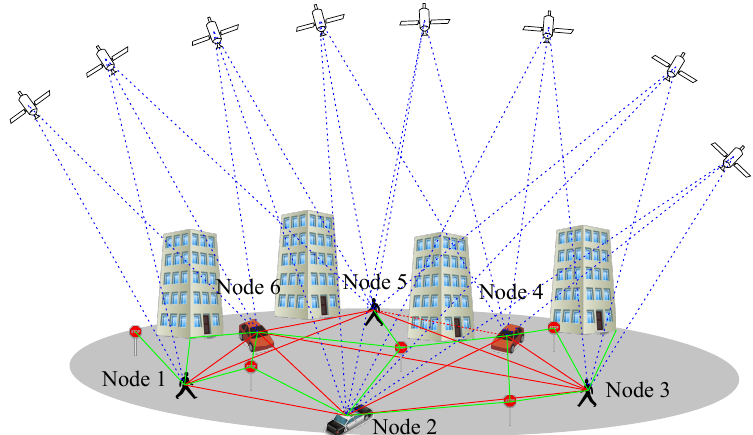
Figure 1. Collaborative positioning by vehicle-to-vehicle, vehicle-to-infrastructure and vehicle-to-pedestrian schemes. In addition, GNSS signals are received. The inter-nodal measurements are carried out using, e.g., laser scanners, stereo cameras and relative GNSS. Vehicle-to-infrastructure measurements are based on laser scanners and stereo cameras with dedicated processing and